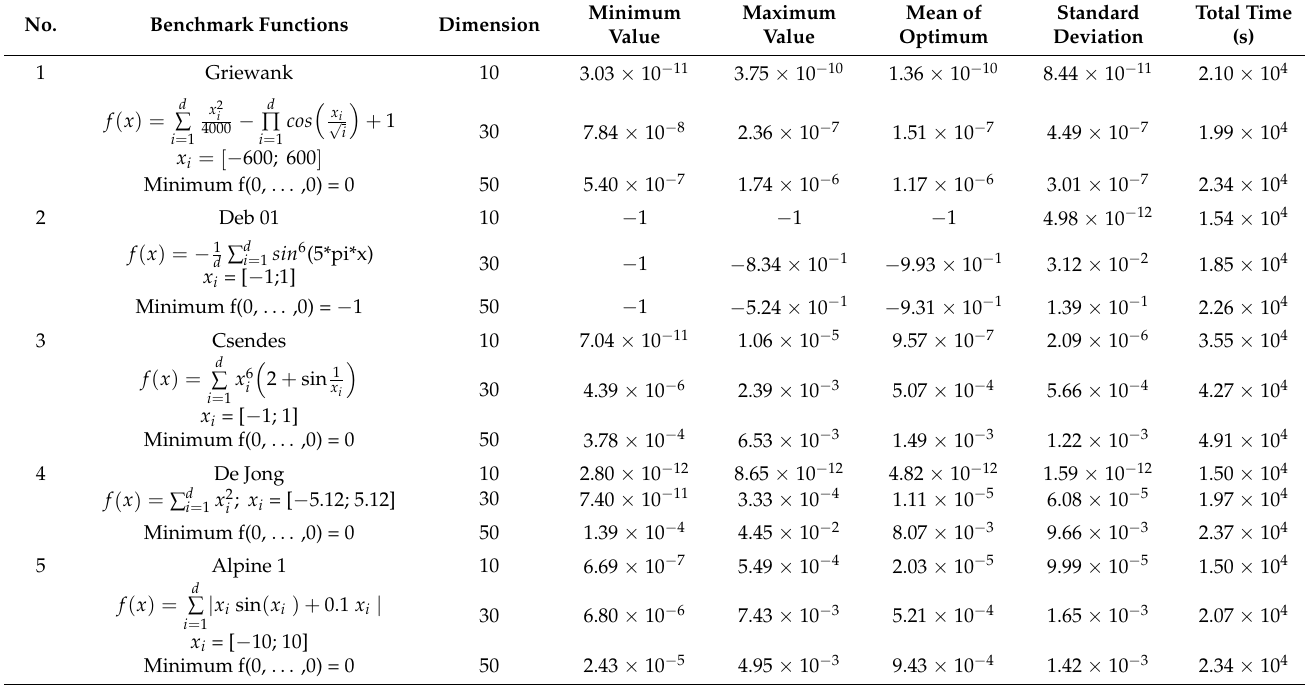
Table 3. Numerical benchmark